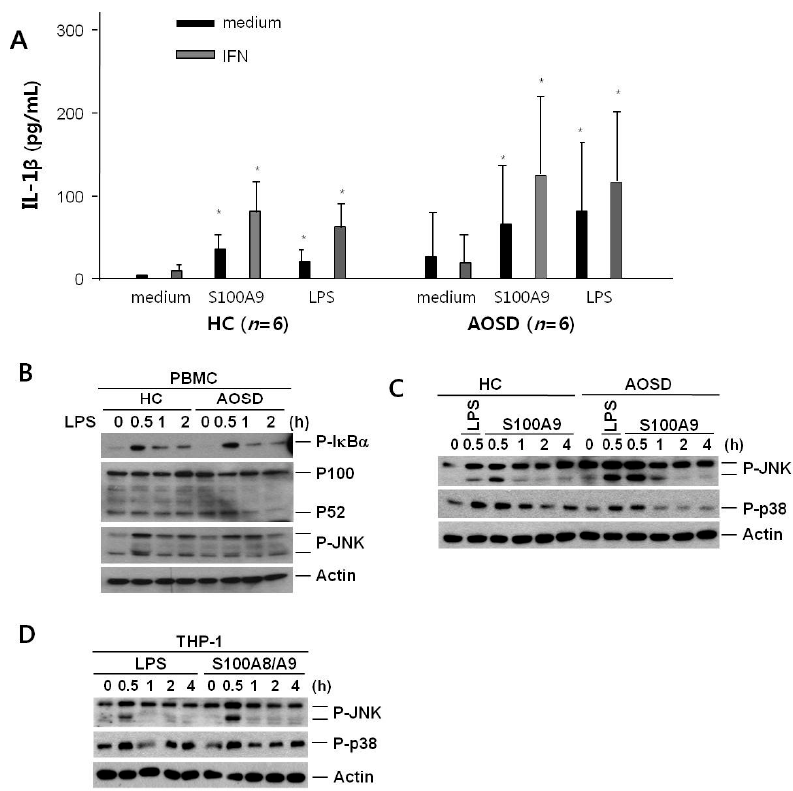
Figure 3. ( A ) Interleukin-1 β (IL-1 β ) secretion after treatment with S100A9 in peripheral blood monocyte cells (PBMCs) of healthy controls (HCs) and patients with active adult-onset Still’s disease (AOSD) patients. PBMCs (1 × 10 6 /mL) were incubated for 24 h with 5 µg/mL S100A9 or 10 ng/mL lipopolysaccharide (LPS) or left untreated as controls (medium). Concentrations of IL-1 β in supernatants were evaluated by enzyme-linked immunosorbent assay. Data are shown from six independent experiments. Values are the means and SD. * p ≤ 0.05, vs. controls; ( B ) Activation of c-Jun amino-terminal kinase (JNK) and p38 after treatment with S100A9 in PBMCs from HCs and patients with active AOSD. PBMCs were treated with LPS or S100A9 for the indicated time. For immunoblot analysis, total cellular proteins were extracted. p100, p52, phosphorylated I κ B α , and JNK in PBMC from HC and AOSD treated with LPS; ( C ) Phosphorylated JNK and p38 in PBMCs from HCs and AOSD patients treated with LPS and S100A9; ( D ) Activation of JNK and p38 in a human monocyte cell line after treatment with S100A8/A9. THP-1 cells were treated with S100A8/A9 or LPS for the indicated time. For immunoblot analysis, total cellular proteins were extracted. Phosphorylated JNK and p38 in THP-1 cells treated with S100A8/9.